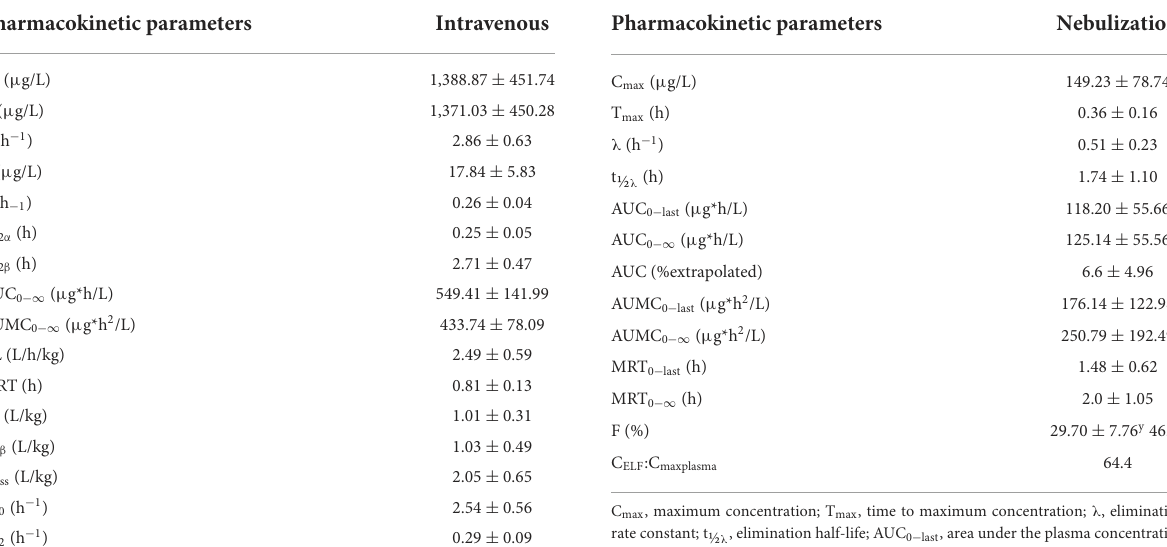
TABLE 3 Pharmacokinetic parameters of lidocaine following a single intravenous 1.3 mg/kg dose in 5 healthy adult horses.